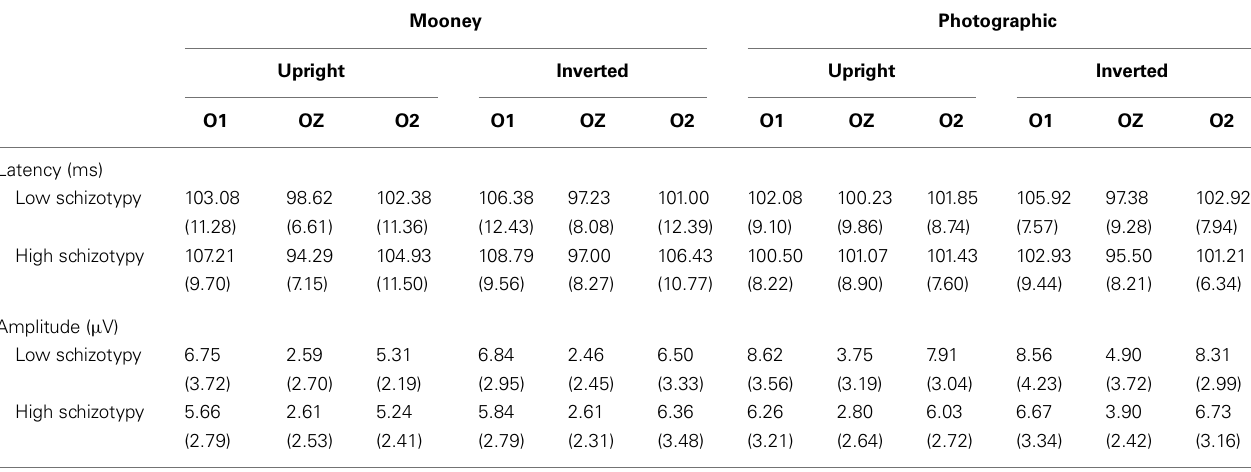
Table 4 | P100 Mean (SD) amplitude and latency per condition and electrode .